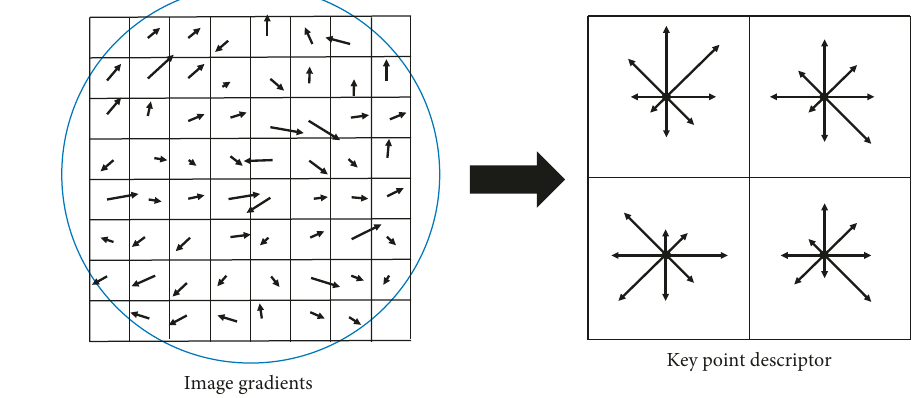
Figure 4: Key point descriptor extraction in SIFT.